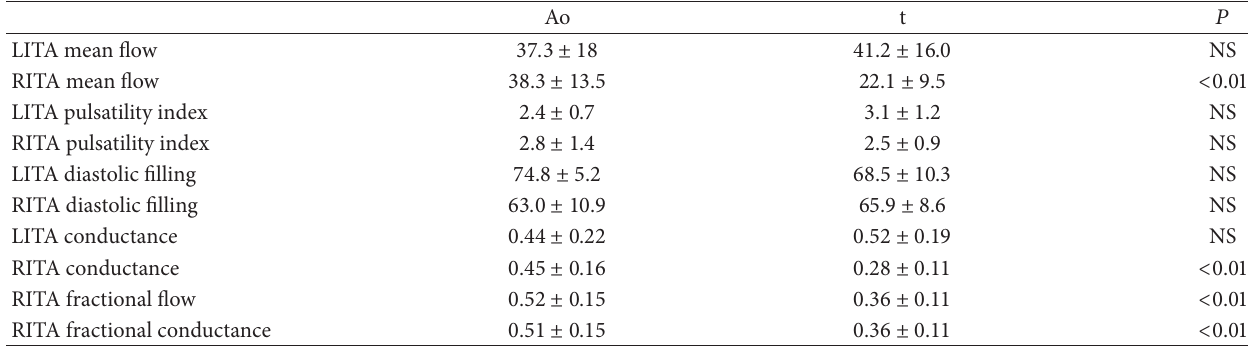
Table 3: Intraoperative flow measurements.